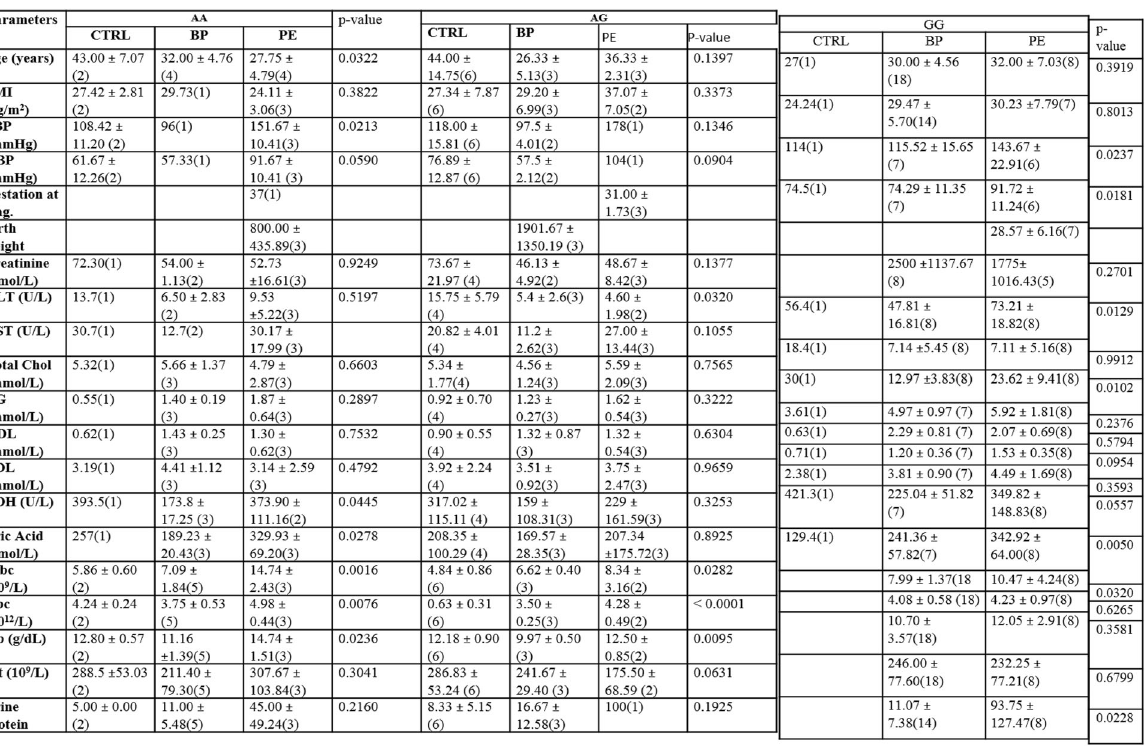
Table 2 Exon 10 FVL stratification with clinical variables